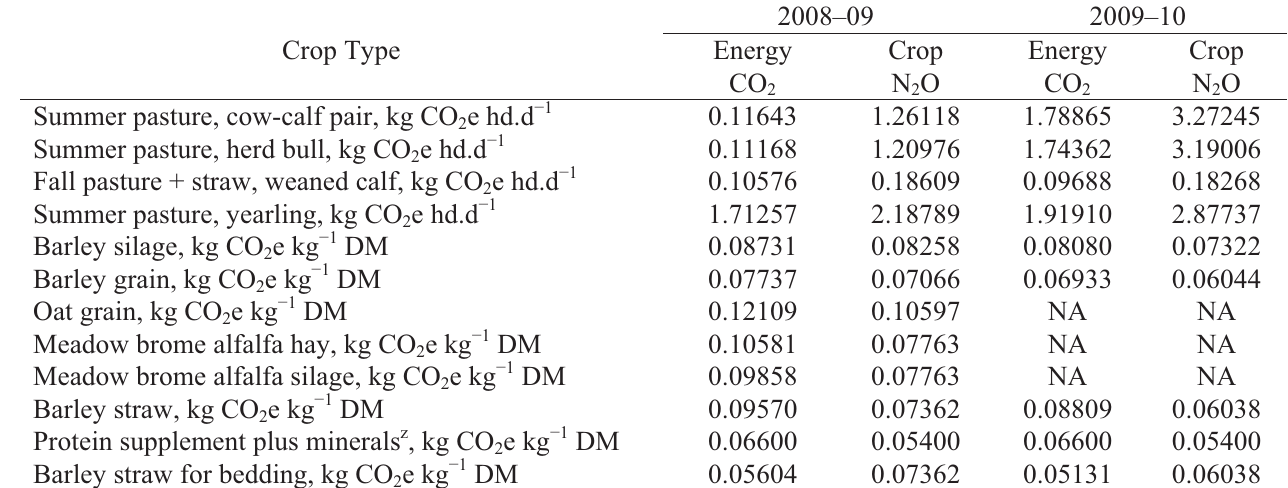
Table A6. Greenhouse gas emission coefficients for energy use x and crop nitrous oxide y O) by crop type and (N 2